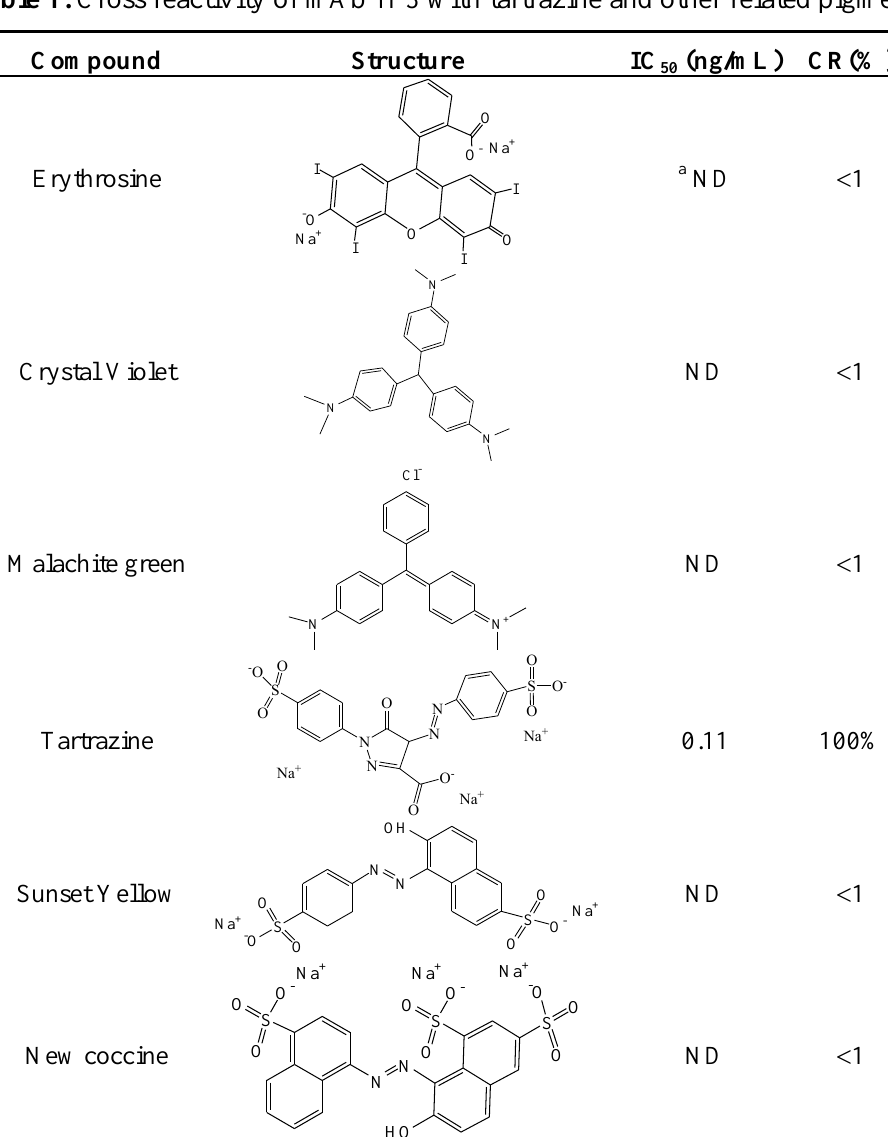
Table 1. Cross reactivity of mAb 1F3 with tartrazine and other related